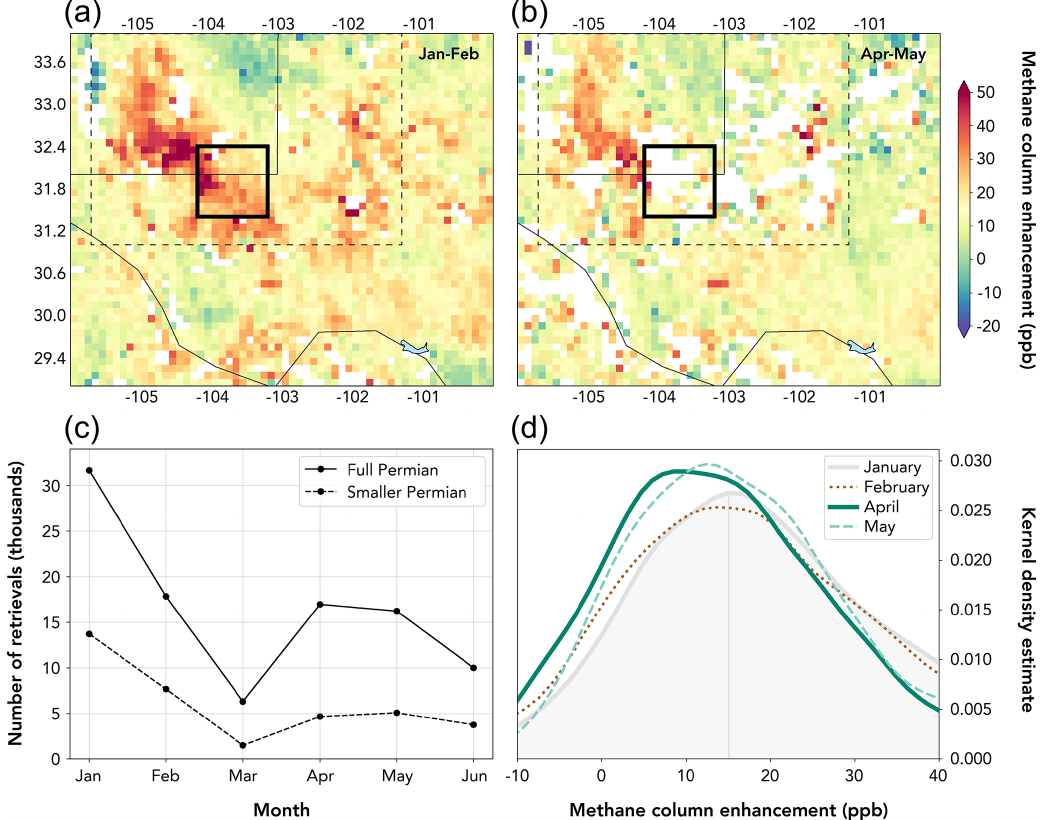
Figure 5. TROPOMI observations of topography-corrected methane column enhancements over the Permian Basin, from January to June 2020. (a–b) Mean methane column enhancements (ppb) over the Permian Basin for the January–February and April–May 2020 time periods, gridded to 0.1 ◦ × 0.1 ◦ resolution. The thin solid lines indicate state and national borders; the thick solid lines describe the 100km × 100km tower and aircraft study region; and the dotted lines trace a smaller Permian Basin domain that closely bounds the methane hotspots seen over the Delaware and Midland subbasins. (c) Number of TROPOMI column retrievals over the full Permian Basin domain (29–34 ◦ N and 100–106 ◦ W) and over the smaller Permian Basin domain (31–34 ◦ N and 101.4–105.6 ◦ W; dashed lines in panels a , b ) by month in 2020. (d) Frequency distribution plots of methane column enhancements over the smaller Permian Basin domain by month, after removal of days without coverage of the Delaware and/or Midland subbasins (see text). The gray vertical line indicates the distribution maximum for